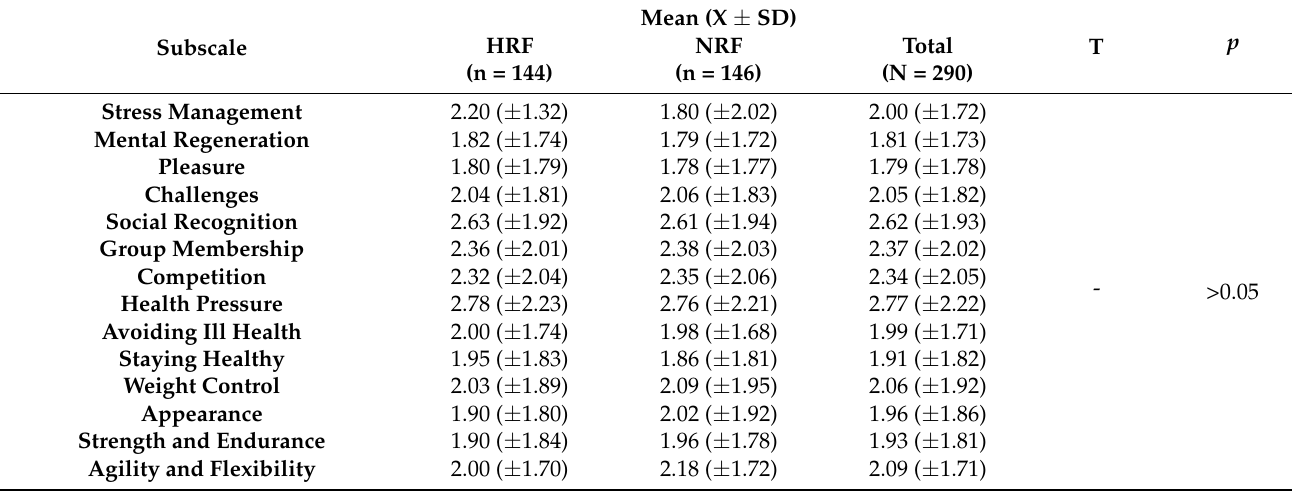
Table 2. EMI-2 subscales by group (N =